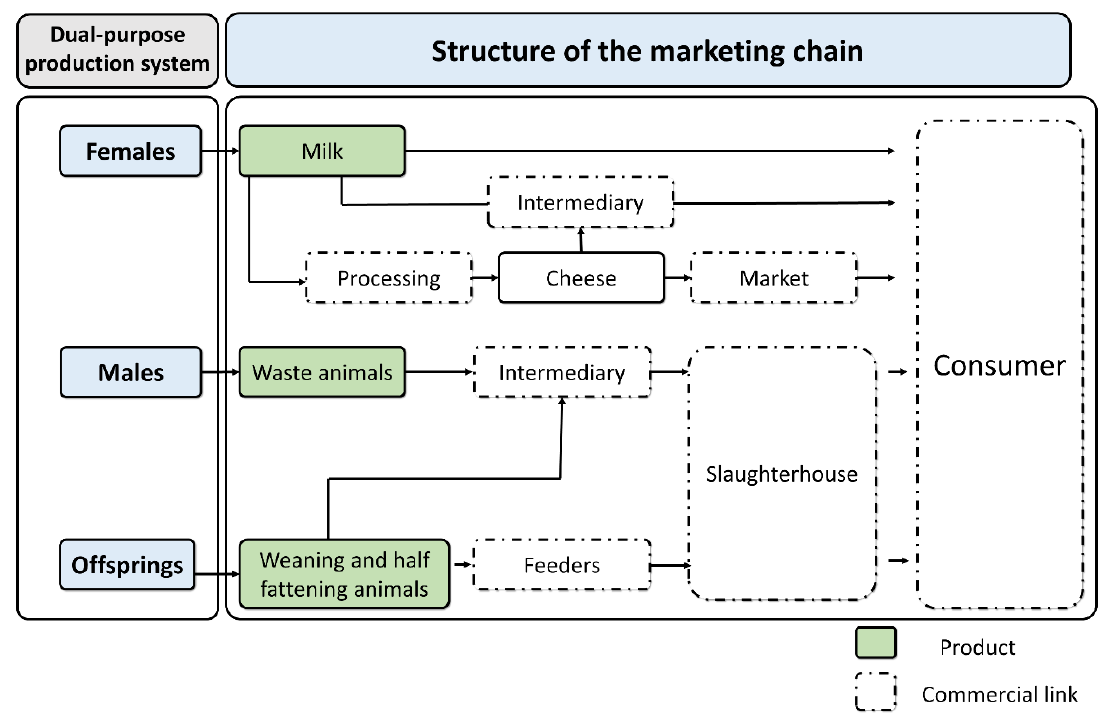
Figure 1. Structure of dual-purpose production systems with river buffaloes.